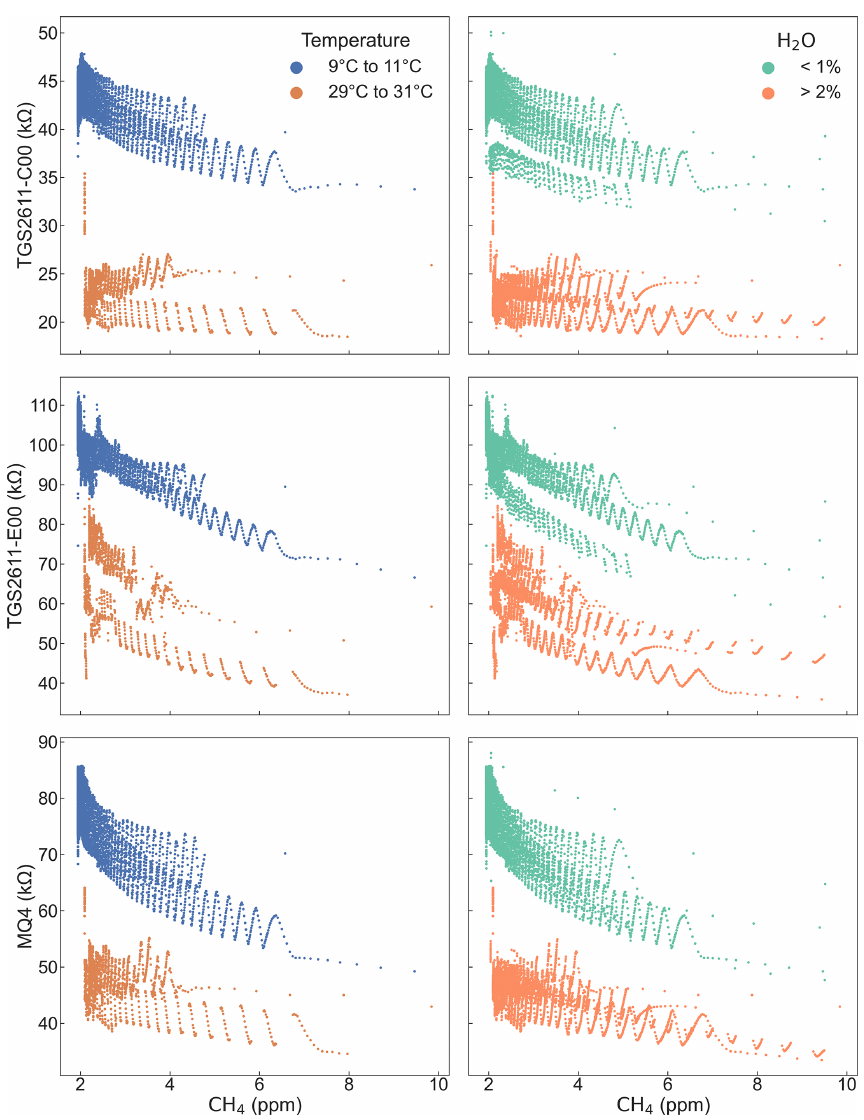
Figure 7. Sensor response ( y axis) to environmental conditions can be greater than to methane ( x axis) at low